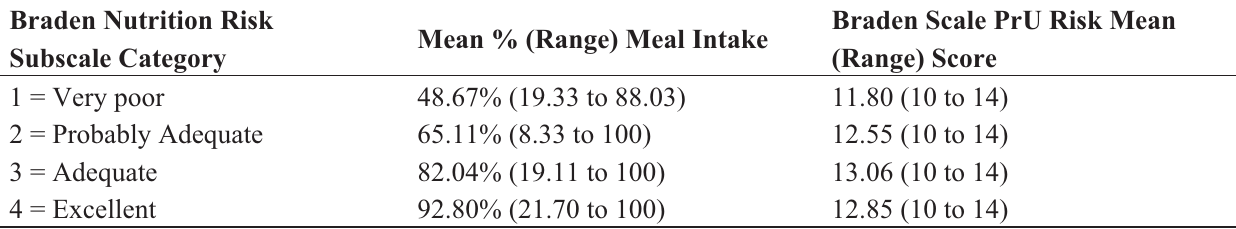
Table 2. Mean and Range of % Meal Intake and Braden Scale PrU Risk Score Grouped According to Braden Nutrition Subscale Risk Categories ( n =